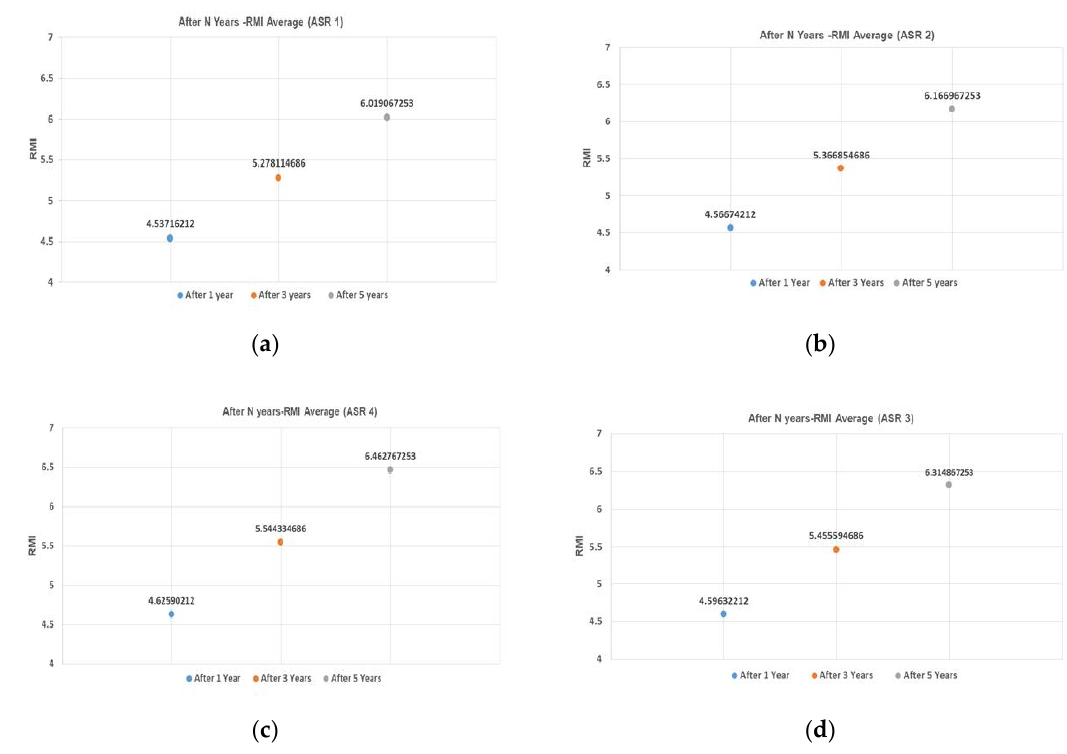
Figure 10. RMI average and ASR grades and after N-years into the future. ( a )ASR grade 1; ( b ) ASR grade 2; ( c ) ASR grade 3; and ( d ) ASR grade